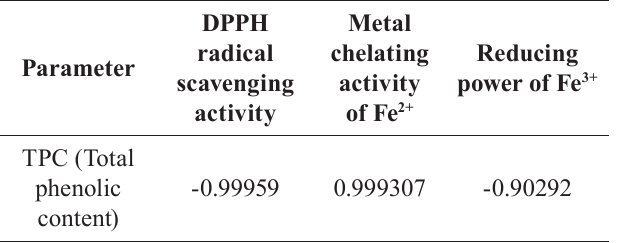
TABLE VI B - Correlation coefficient between various